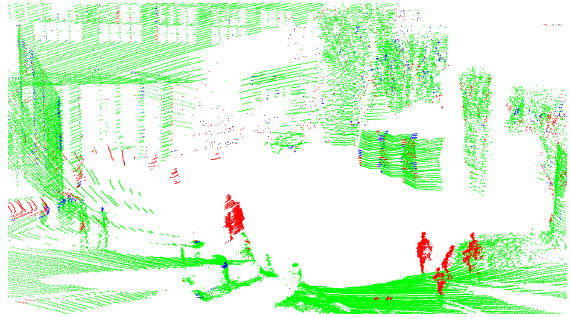
Figure 6. A labeled scan from the Inner Yard subset. The point clouds are divided into the categories moving object (red), static structure (green) and undetermined (blue).